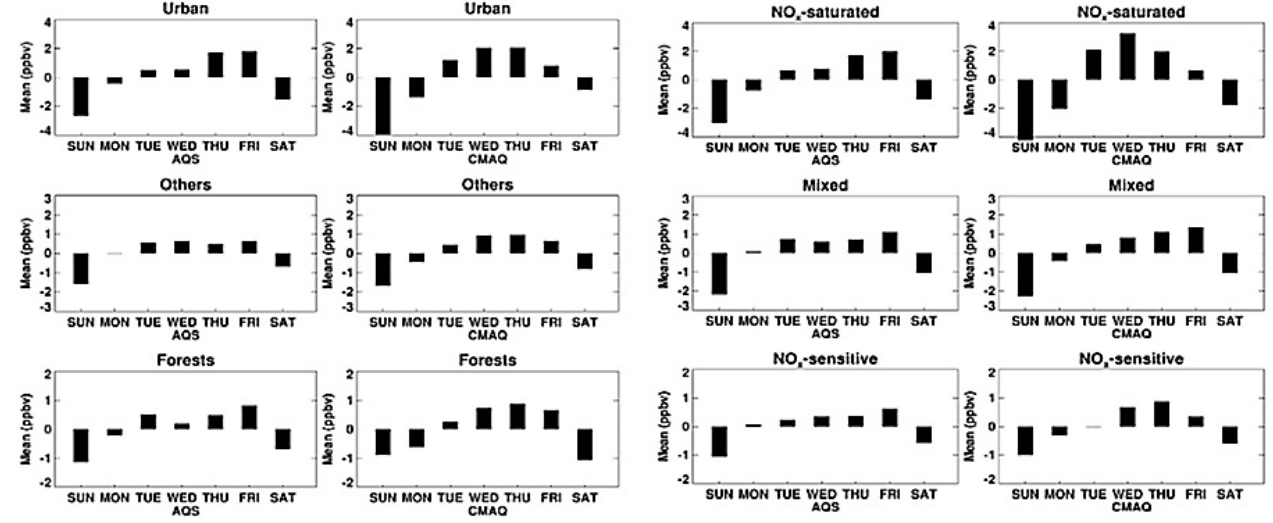
Fig. 6. Weekly anomalies of AQS-observed and CMAQ-simulated ground-level NO x concentrations at EPA AQS stations over AVHRR- derived geographical regions (i.e., urban, other, and forest regions, left two columns) and GOME-2-derived chemical regimes (i.e., NO x - saturated, mixed, NO x -sensitive regimes, right two columns) for August 2009. For the sake of consistency with the daytime O 3 comparison in Fig. 7, only daytime (01:00–05:00p.m., local time) NO x concentrations are used; some data are filtered out from 17–19 August 2009, when Tropical Storm Ana strongly affected air quality over the eastern